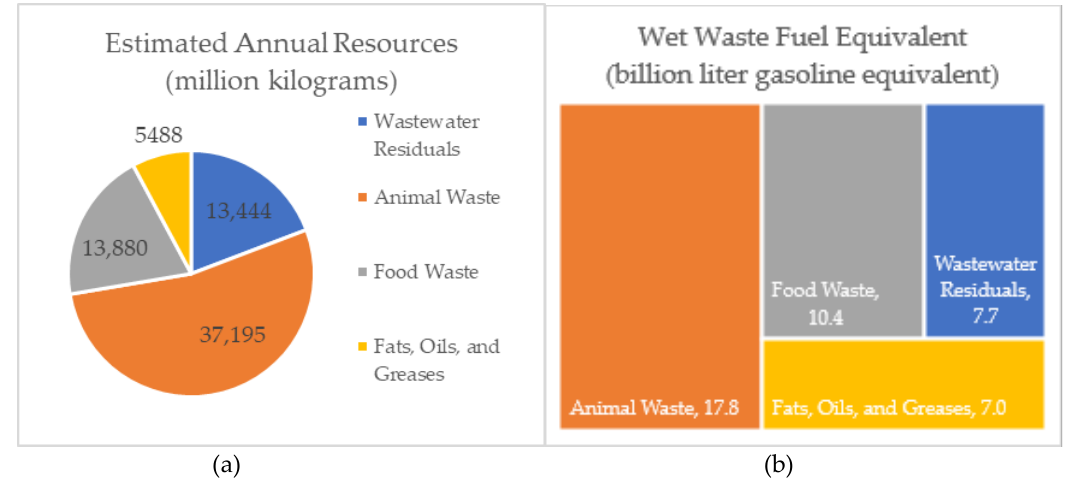
Figure 1. ( a ) Availability of wet wastes in theU.S.; ( b ) Wet waste energy potential in the U.S. [6] . 1 kilogram = 0.0011 U.S. tons; 1 liter = 0.264 U.S. liquid gallons.